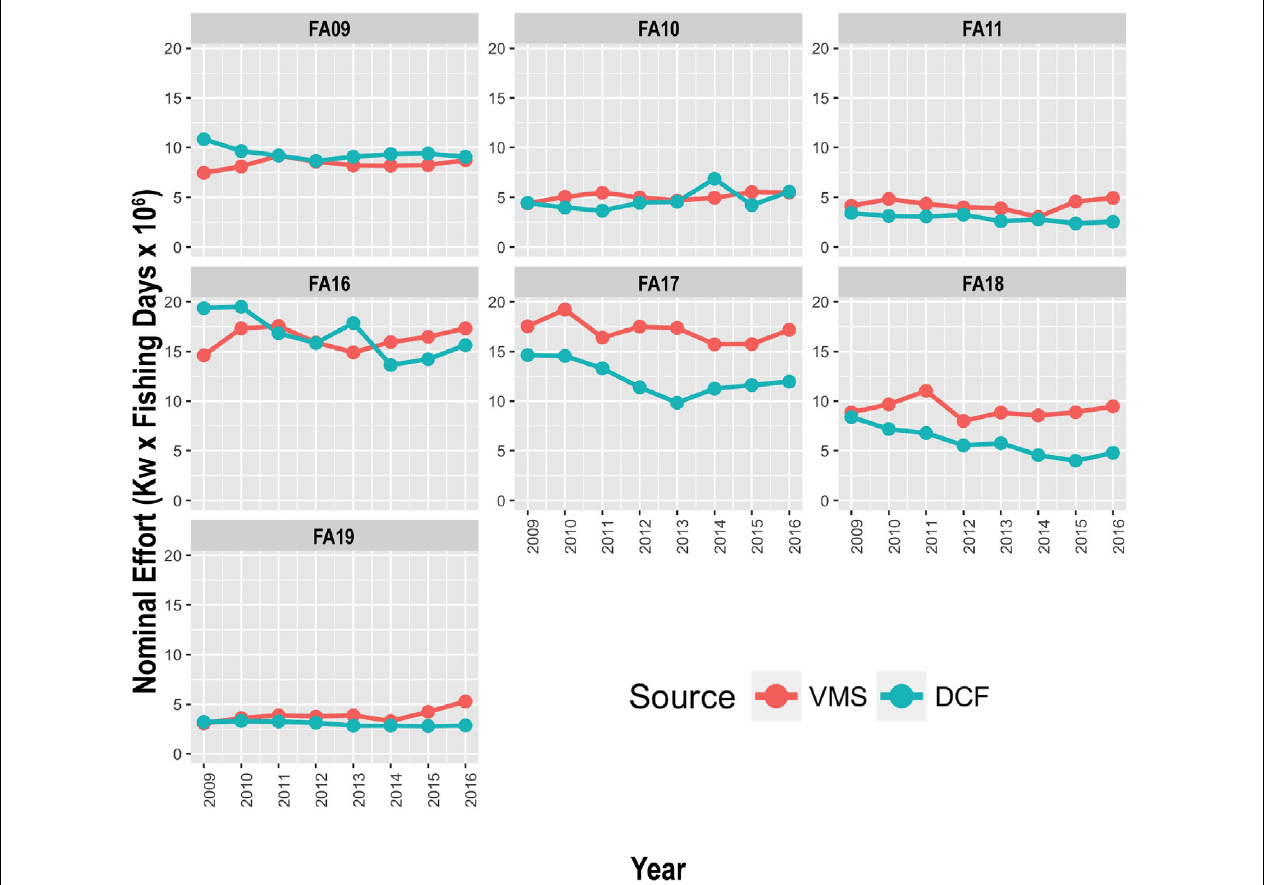
FIGURE 5 | Comparison of DCF trends for the Nominal Effort (NE in Kw × Days of fishing × 106) with the one obtained using the VMS